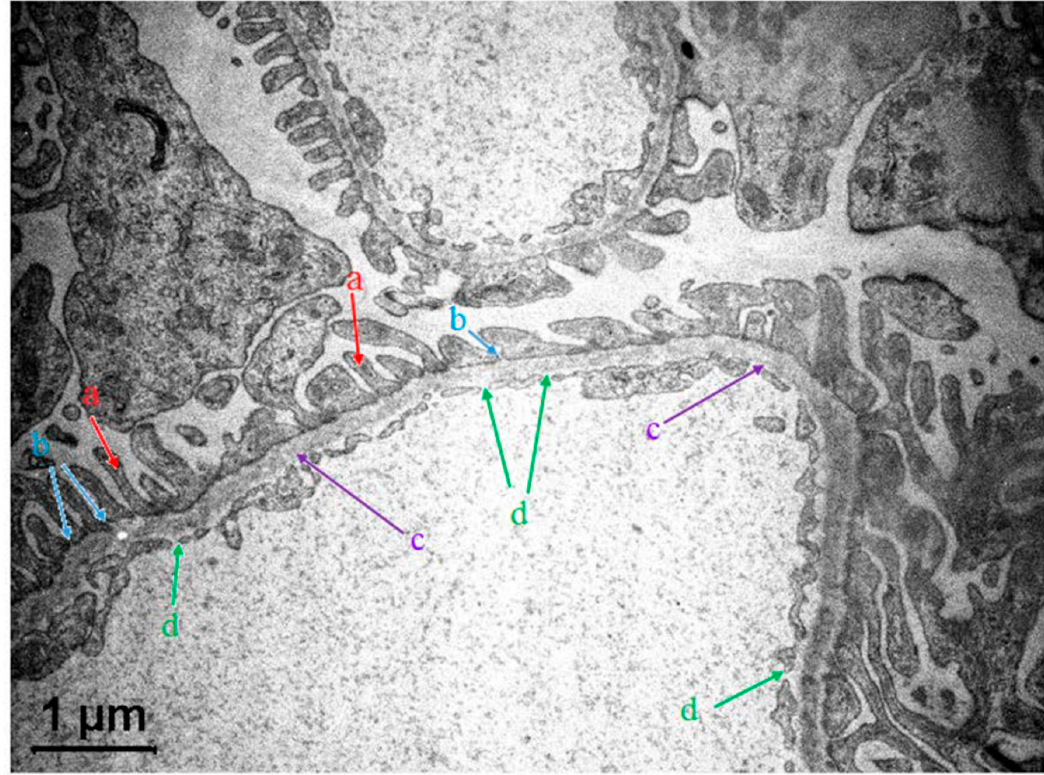
Figure 1. An electron microscopy of the glomerular filtration barrier (GFB) layer structure with podocytes (a, shown with red arrows), slit diaphragms (b, blue arrows), glomerular basement membrane (c, violet arrows) and endothelial fenestrae (d, green arrows).